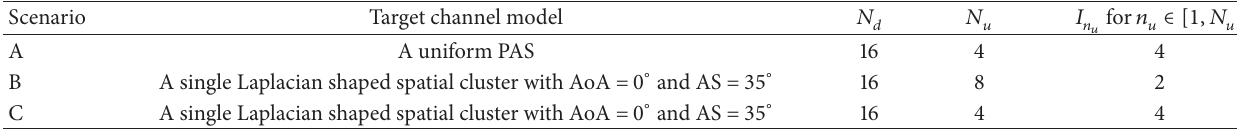
Table 1: Details of the three representative channels.